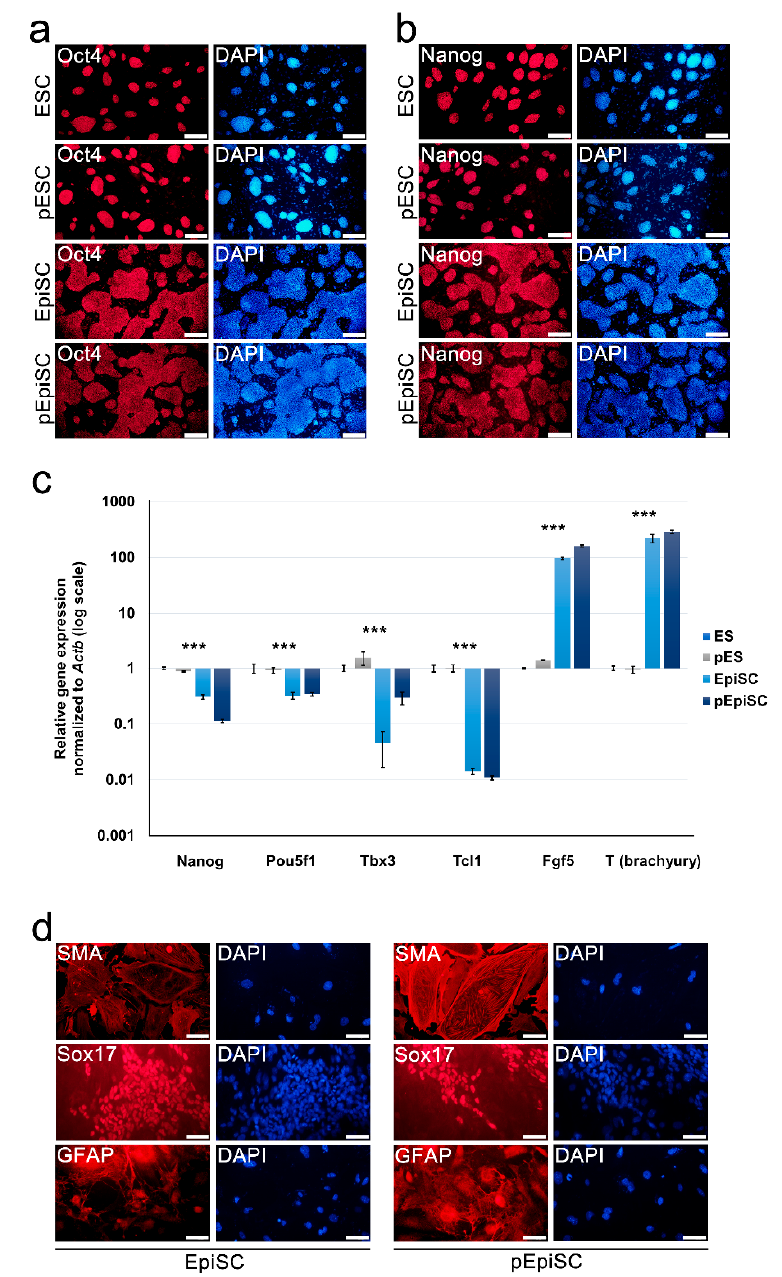
Figure 2. Pluripotency and differentiation potential of pEpiSCs, EpiSCs, parthenogenetic embryonic stem cells (pESCs), and ESCs. ( a,b ) Immunocytochemistry using anti-Oct4 and anti-Nanog antibodies in pEpiSCs, EpiSCs, pESCs, and ESCs. All parthenogenetic and biparental pluripotent stem cell types expressed the core pluripotency markers Oct4 ( a ) and Nanog ( b ). Nuclei were stained with DAPI (blue). Scale bars represent 200 µm. ( c ) Real-time RT-PCR analysis of pEpiSCs, EpiSCs, pESCs, and ESCs for the expression of naïve and primed pluripotency-related genes. Data are presented as the mean ± SEM for n = 3 independent experiments. *** p -value < 0.001 ( d ) In vitro differentiation by embryoid body formation with pEpiSCs and EpiSCs. Both pEpiSCs and EpiSCs could differentiate into mesoderm (smooth muscle actin, SMA), endoderm (Sox17), and ectoderm (glial fibrillary acidic protein, GFAP) lineages. Scale bars represent 100 µm.